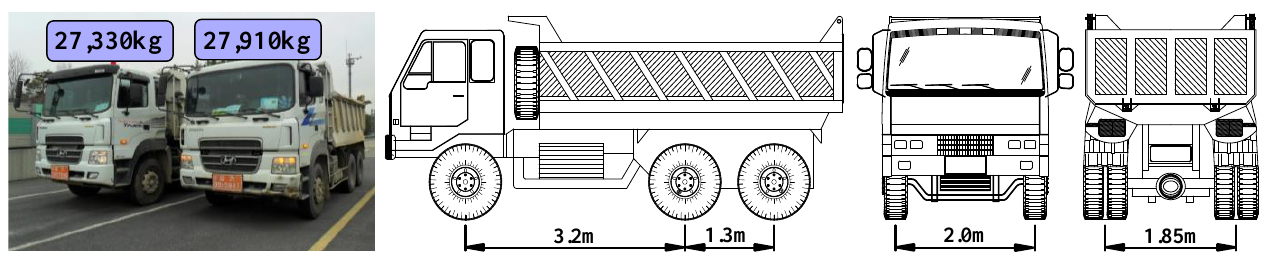
Figure 4. LVDT installation positions.